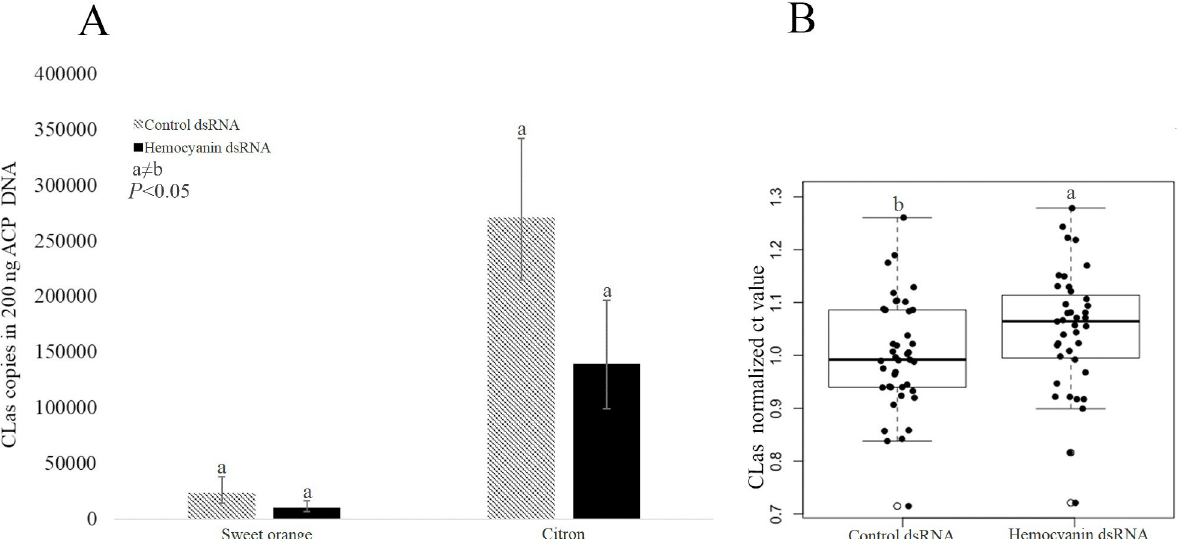
Fig 8. C Las titer 10-days post injection in blue color morph adult D . citri . (A) The copy number of C Las in hemocyanin silenced blue color morph reared on sweet orange and citron compared to non-silenced D . citri . Reduction in C Las titer in hemocyanin silenced insects was not statistically significant when data from different host plants are considered separately but was significant when normalized values of both host plants were considered together (B) Box plot analysis of normalized Ct values in control and hemocyanin dsRNA treated insects from both host plants. The increase in C Las qPCR Ct values in hemocyanin dsRNA treated insects represents a reduction in C Las titer. Sweet orange D . citri : n = 20; citron D . citri : n =